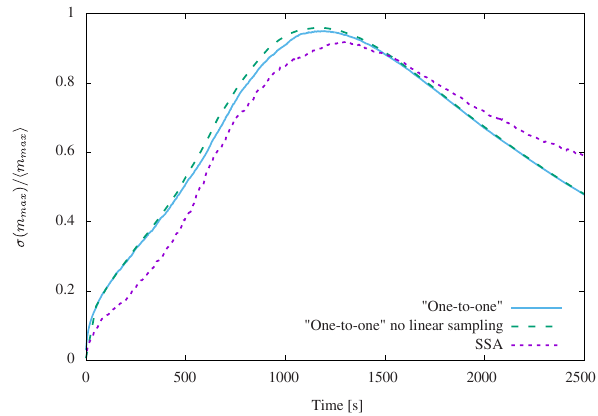
Figure 2. Relative standard deviation of the mass of the largest droplet in the system. Details of the SDM simulations are given in the caption of Fig. 1. The size of the ensemble of SSA simulations is (cid:127) = 10 3 . The SSA results are taken from Fig. 7 in Alfonso and Raga (2017) (data courtesy of L. Alfonso).